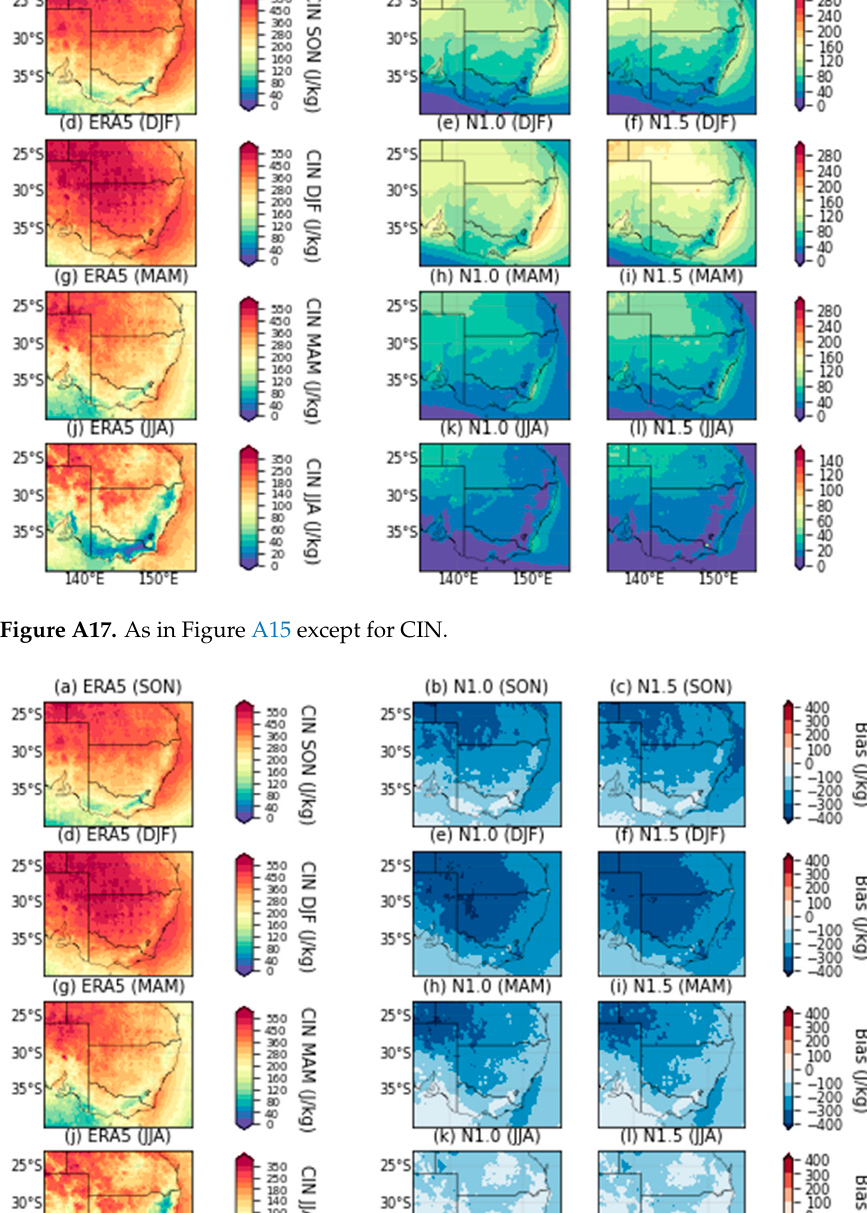
Figure A16. Climatology of MUCAPE in d02 from ( a , d , g , j ) ERA5; biases ii ( b , e , h , k ) N1.0 and ( c , f , i , l ) N1.5 during SON (row 1), DJF (row 2), MAM (row 3) and JJA (row 4). The colorbar for climatology is as in Figure A15. Unit: J kg − 1 .